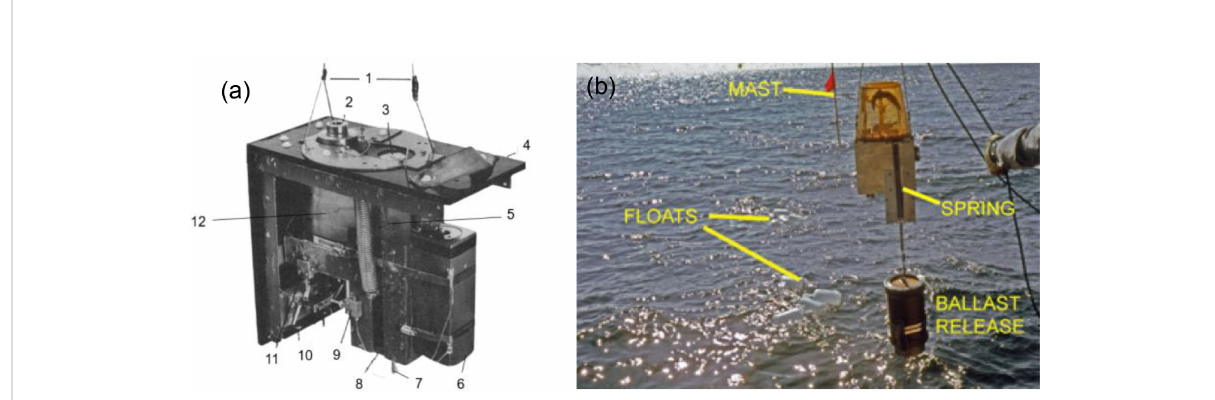
FIGURE 3 Photos of PRAT (A) detailed structure of PRAT. 1: The cable connected to the fl oats;2: Window;3: The piston end;4: Insulating box;5: Springs;6: Accumulator;7: The rod connected to the ballast;8: The stop of piston;9: Valve for charging of nitrogen;10 and 11: Valves connected to high- pressure seawater circulating system; 12: the trap body; (B) fi eld test of PRAT (adapted from Yayanos, 1978; Yayanos,